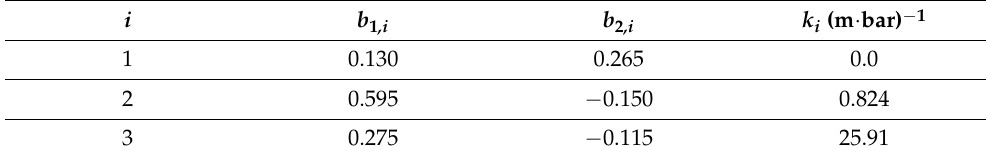
Table 1. Coefficients for Equation